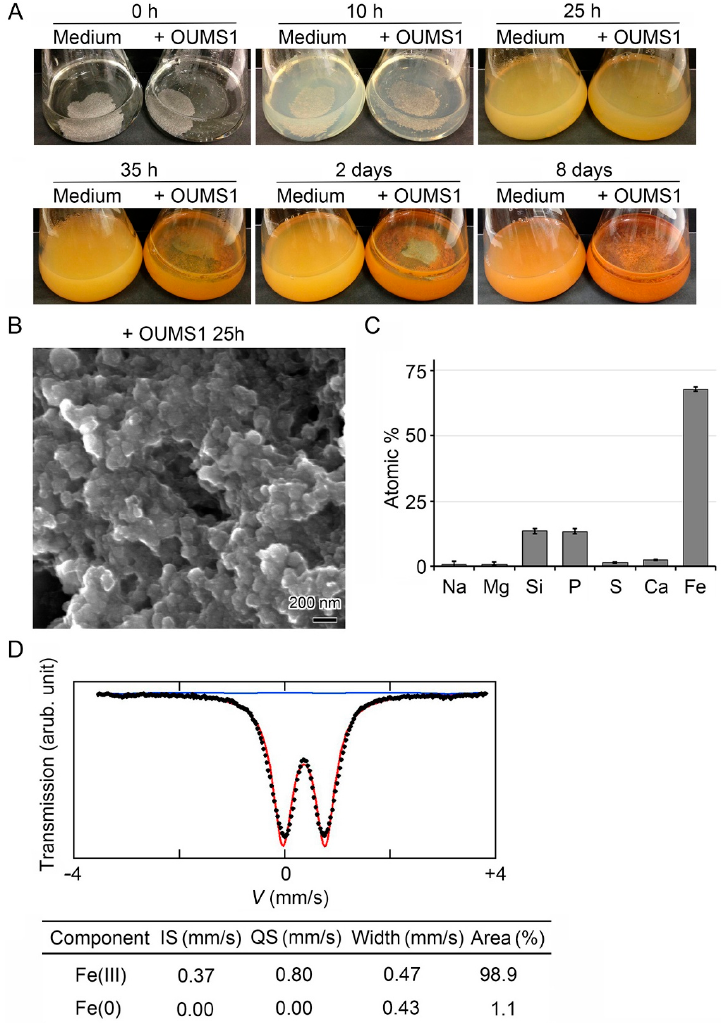
Figure 2. Adherence of Fe(III) particles abiotically generated in SGP + Fe medium to OUMS1 primitive sheaths. ( A ) Visual changes in medium turbidity in uninoculated ( left ) or inoculated ( right ) SGP + Fe; ( B ) SEM image of the particles harvested with OUMS1 from SGP + Fe after 25 h incubation; ( C ) Mean (± s.d.) atomic percentages of detectable major inorganics in the particles harvested with OUMS1 from SGP + Fe after 25 h incubation (determined by EDX). n = 10 spots per sample; ( D ) Mössbauer spectra of Fe particles harvested with OUMS1 from SGP + Fe after 25 h incubation. Note that the Fe component consisted of nearly 99% Fe(III) and 1% Fe(0) probably derived from the iron powder added to the medium.